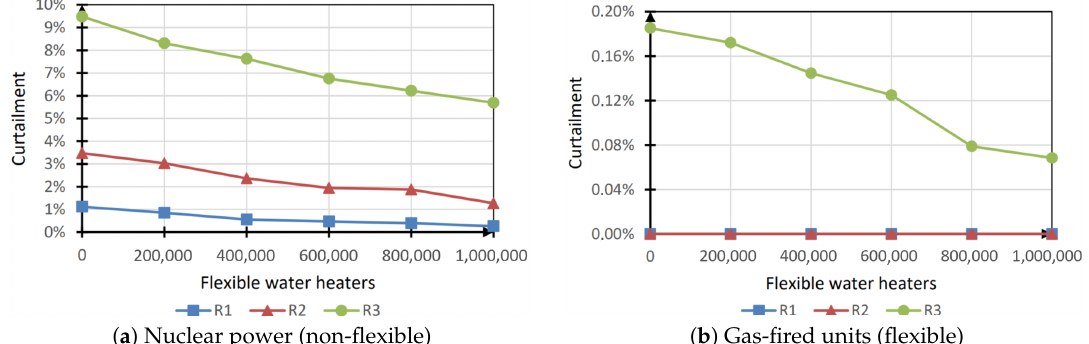
Figure 7. Curtailment (water